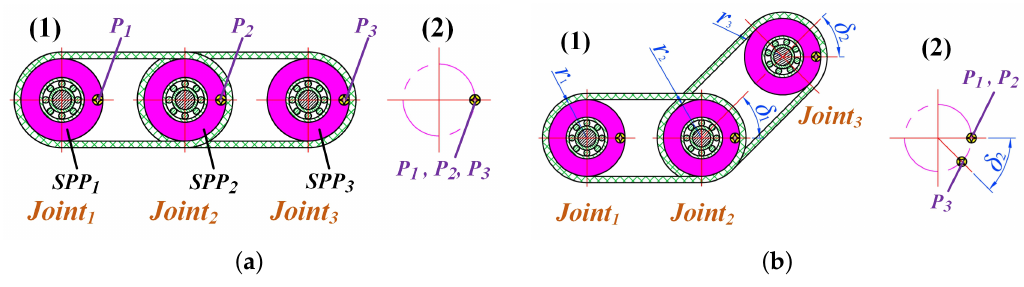
Figure 12. ( a ) The status of power pulleys before the Joint 2 is driven to rotate. ( b ) The status of power pulleys after the Joint 2 is driven to rotate. ( b ) is the phase difference of the P 3 after the Joint 2 is rotated δ 1 relative to ( a ). r 1 – r 3 are the radii of the SPP 1 – SPP 3 . P 1 – P 3 are the mark points of SPP 1 – SPP 3 . The ( a )–2 and ( b )–2 is the phase relationship of P 1 – P 3 .